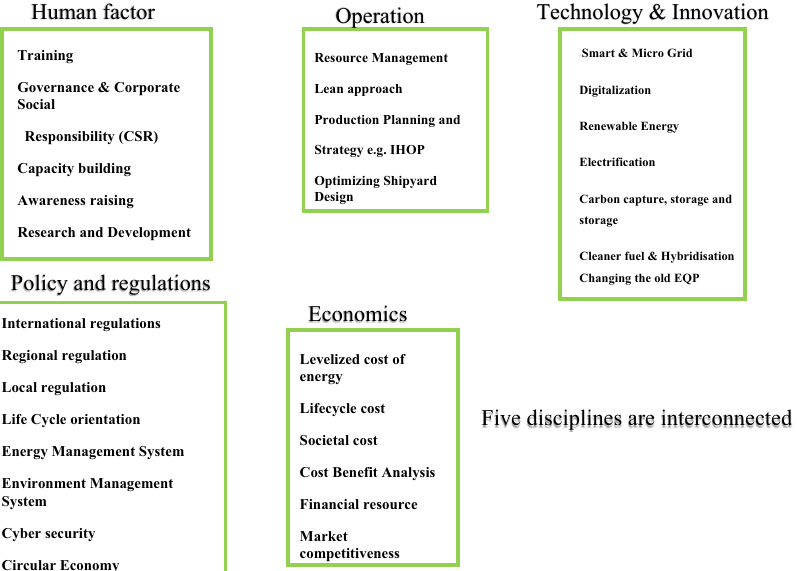
Fig. 6 Selected measures and tools in five main criteria for the studied